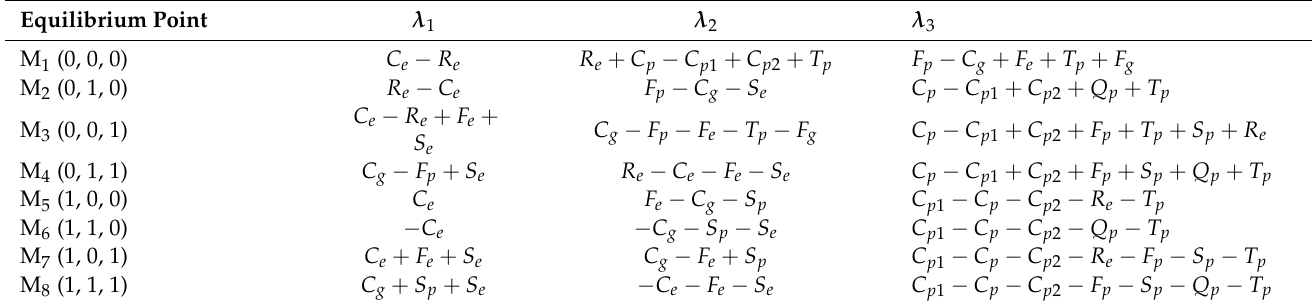
Table 2. Jacobian matrix